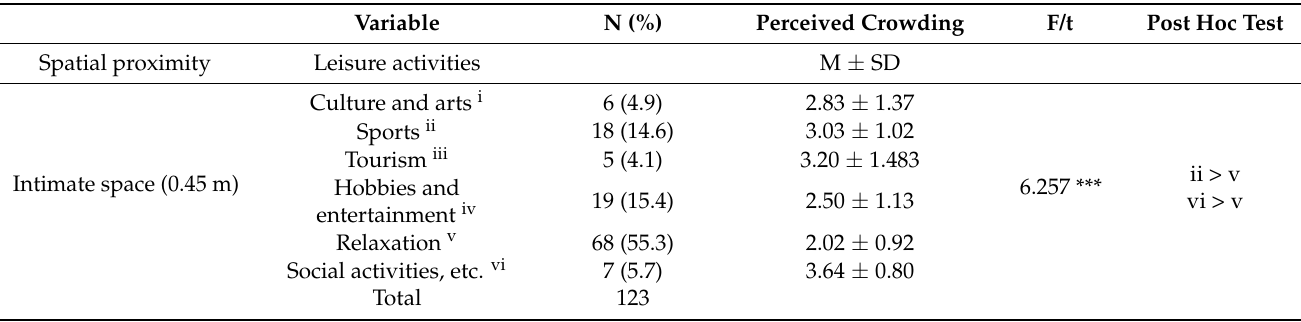
Table 2. Differences in Perceived Crowding According to the Leisure Activity Type in Different Spatial Proximity Zones (N =